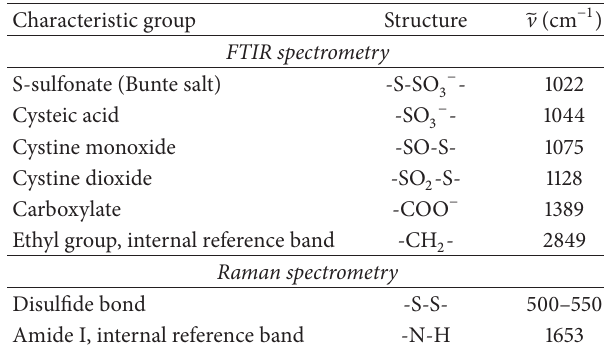
Table1:Characteristicwavenumbersoffunctionalgroupsfornative wool used in FTIR and Raman spectroscopy [25, 26].